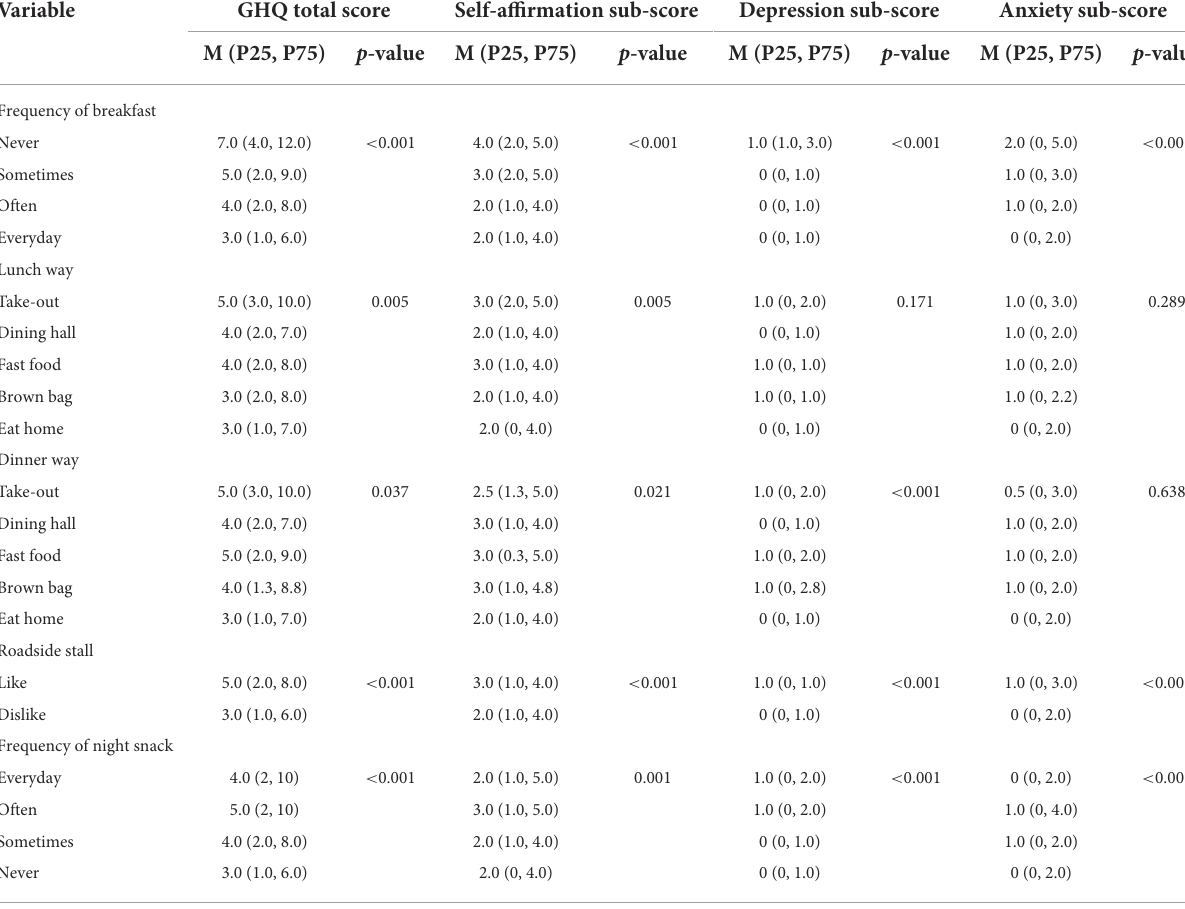
TABLE 3 Nutritional behavior based on GHQ total score, self-affirmation sub-score, anxiety sub-score, and depression sub-score of the sample.